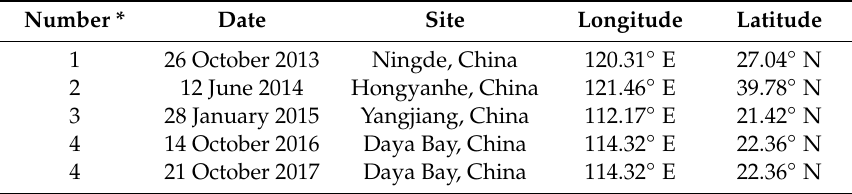
Table 2. Field experiment information (* Numbers correspond to Figure 1).